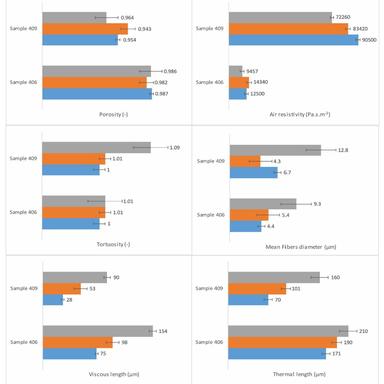
Intrinsic and acoustic parameters for samples 406 and 409. Left panel: porosity, tortuosity and viscous length (from top to bottom). Right panel: air resistivity, mean fibers diameter and thermal length (from top to bottom). Colors: experimental data Kerdudou et al. (blue), scan at 1 μm (orange) and scan at 3.5 μm (gray). (For interpretation of the references to color in this figure legend, the reader is referred to the web version of this article.)